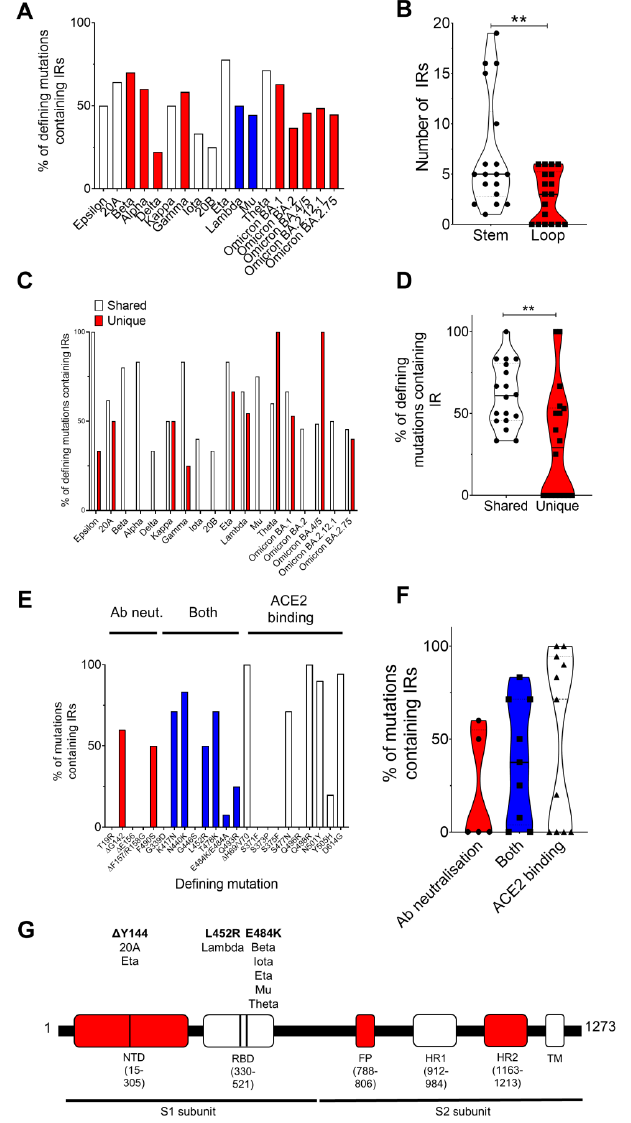
Figure 1. Defining SARS-CoV-2 spike protein mutations involved in ACE2 binding and antibody neutralization are found within inverted repeats (IRs) and predicted pseudoknots. ( A ) The percentage of defining spike protein mutations falling within IRs differed considerably between the variants investigated. ( B ) Spike protein mutations were more likely to fall within the stem, rather than the loop, of the predicted secondary hairpin stem-loop structure. ( C , D ) Spike protein mutations which frequently occurred in more than one variant (shared) were significantly more likely to occur within IRs compared to mutations which were unique to a variant. ( E , F ) Spike protein mutations associated with ACE2 binding were more frequently found within IRs, whereas mutations associated with antibody neutralization were found infrequently within IRs. Mutations implicated in both are highlighted in blue. ( G ) In the Wuhan strain, pseudoknots were predicted to form within, or within 20 bp, of the ∆ Y144, L452K, and E484K mutations involved in antibody neutralization and ACE2 binding within the NTD and RBD of the SARS-CoV-2 spike protein. Those variants sharing these predicted pseudoknots are listed. IRs were detected using Palindrome Analyser with the default settings (size: 6–30 bp, spacer: 0–10 bp, and mismatches: 0, 1) and pseudoknot predictions were performed using ProbKnot in the RNAstructure program. ** indicates a significant difference ( p < 0.05). Data were tested for normality via Shapiro–Wilk prior to comparison via an unpaired Student’s t -test. NTD, N-terminal domain; RBD, receptor-binding domain; FP, fusion peptide;